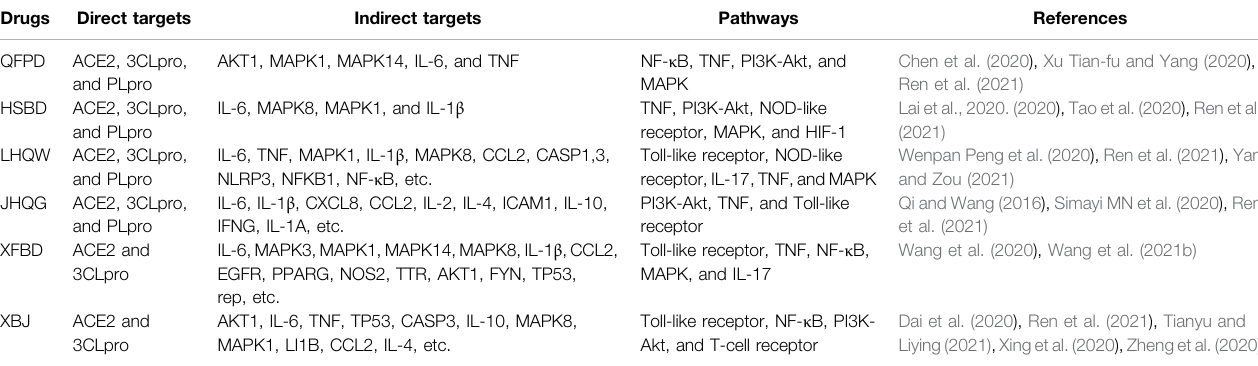
TABLE 3 | Possible mechanism of action of the National Health Commission (NHC)-approved Chinese drugs against